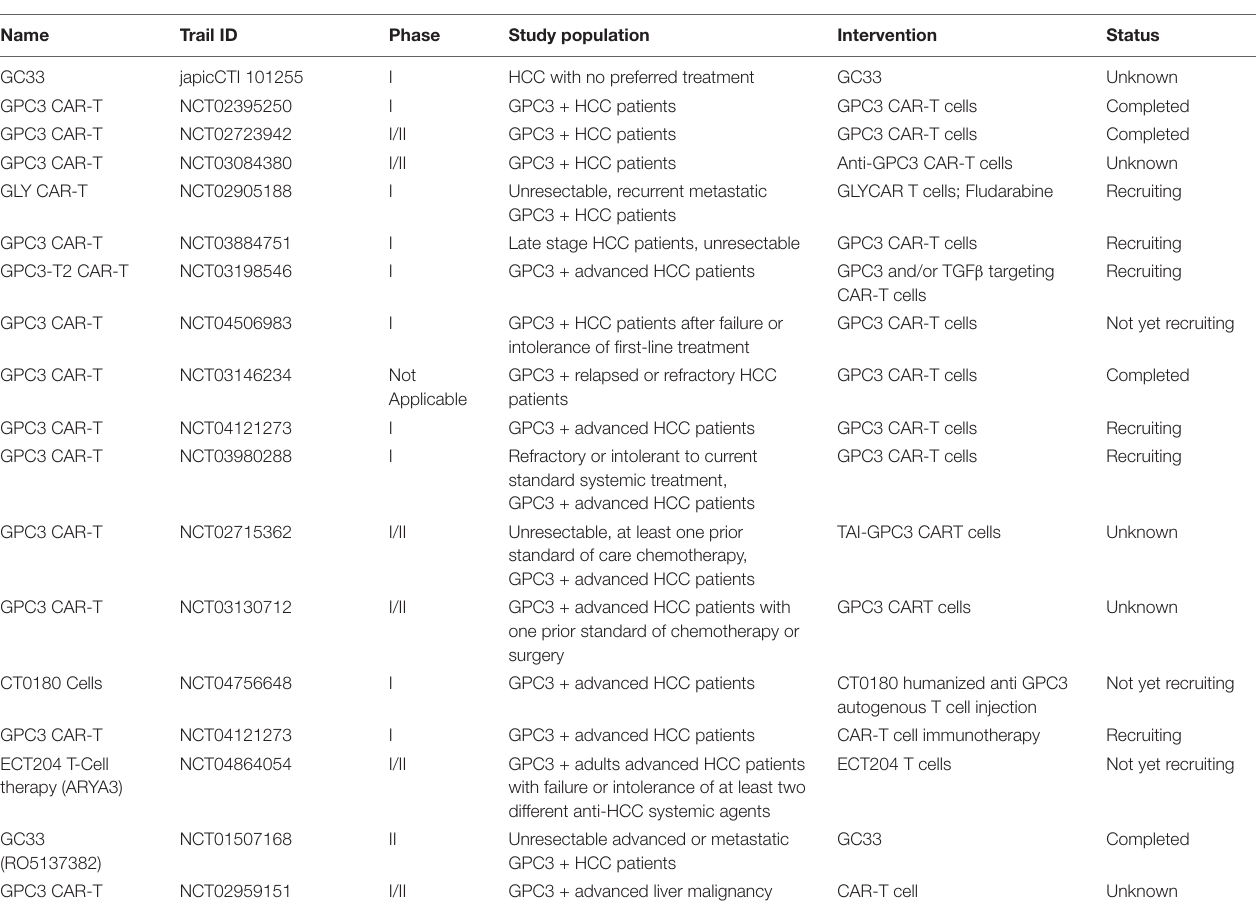
TABLE 4 | Ongoing clinical trials involving GPC3 in